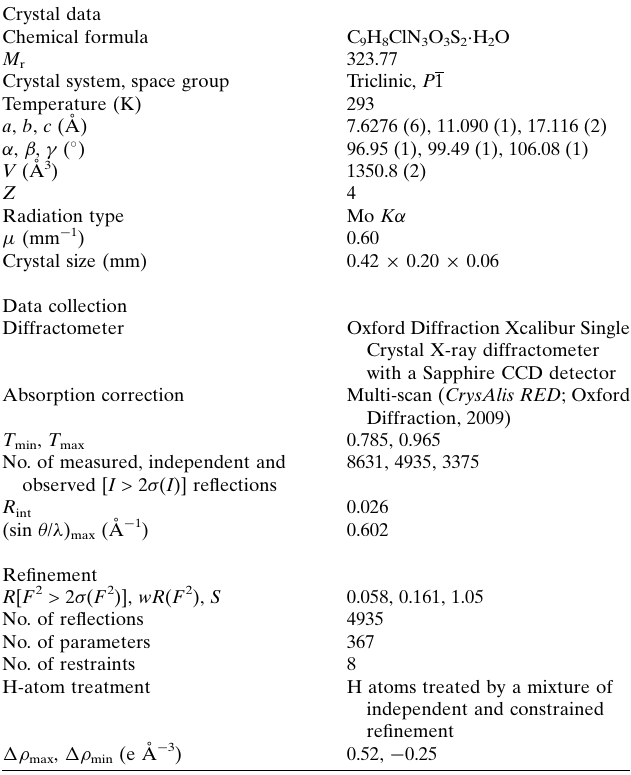
Crystal data Chemical